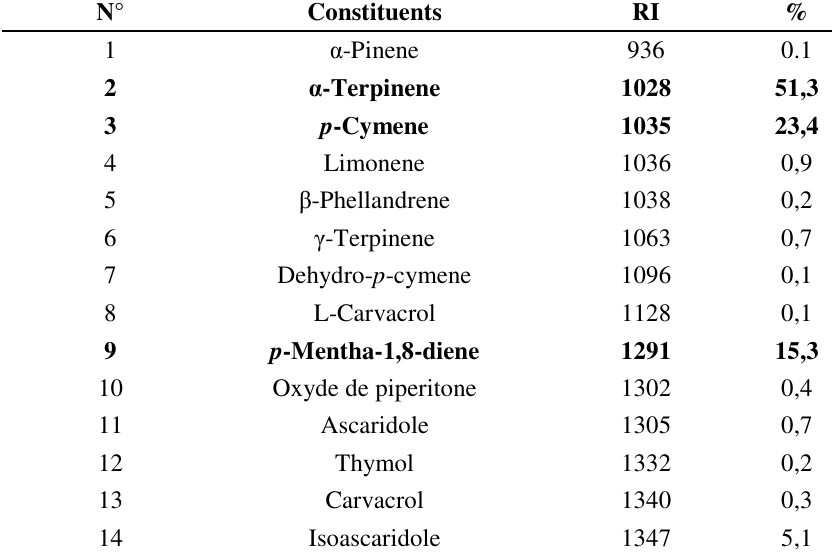
Table 1. Chemical composition (%) of the essential oil of the aerial part of C. ambrosioides. N° Constituents RI % 1 α -Pinene 936 α -Terpinene 1028 p -Cymene 4 Limonene γ -Terpinene Dehydro- p -cymene p -Mentha-1,8-diene 1291 10 Oxyde de piperitone 11 Ascaridole Thymol Carvacrol 14